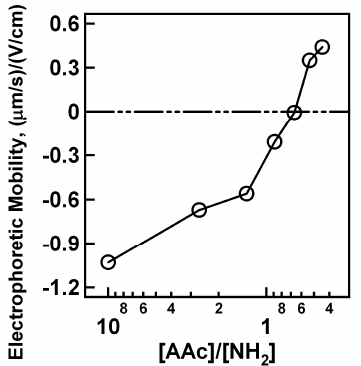
Figure 3. Electrophoretic mobility values as a function of PAH addition for 2% BIS and 10% AAc nanogels upon 0.5 μ L PAH aliquot additions. Note the pH of solutions adjusted at 6.5 with 10 mM NaCl.